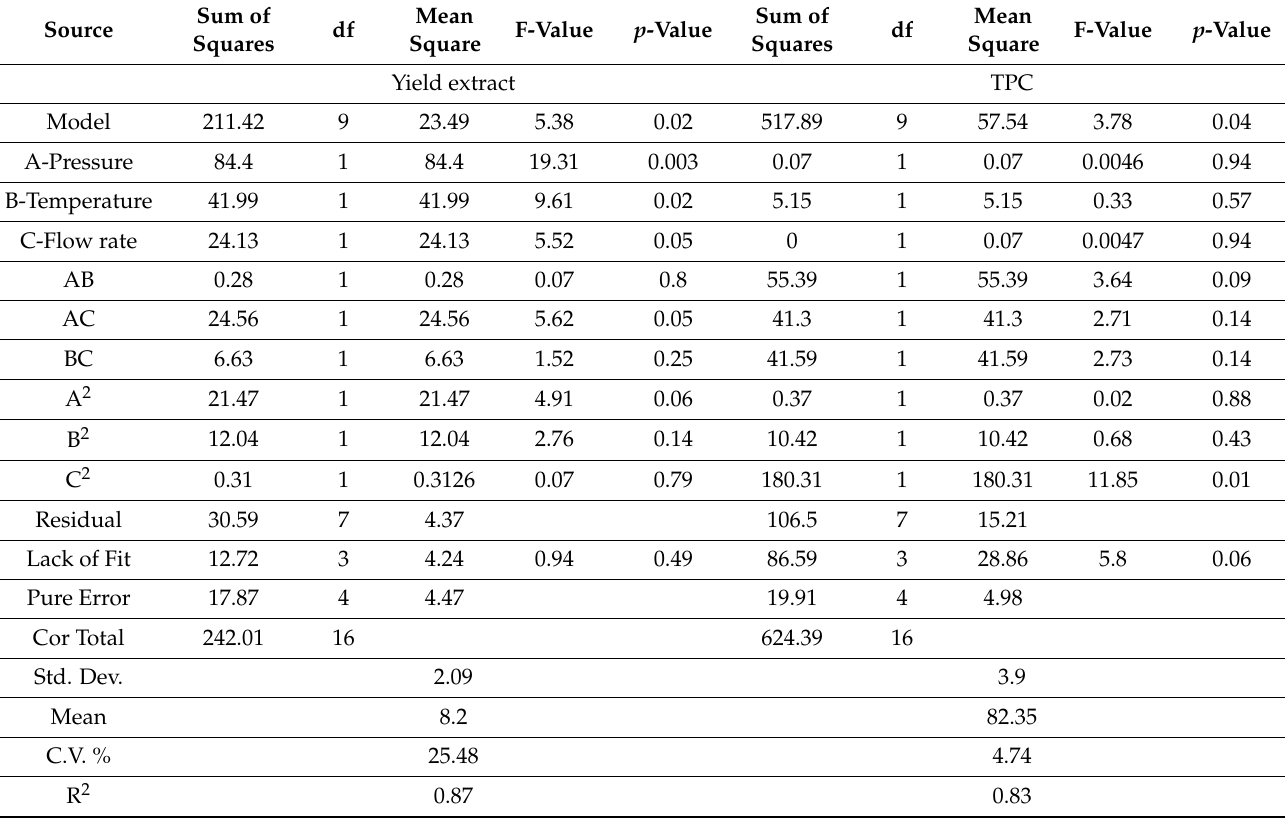
Table 2. ANOVA table and coefficient of models for the response of yield for ScCO 2 extraction.